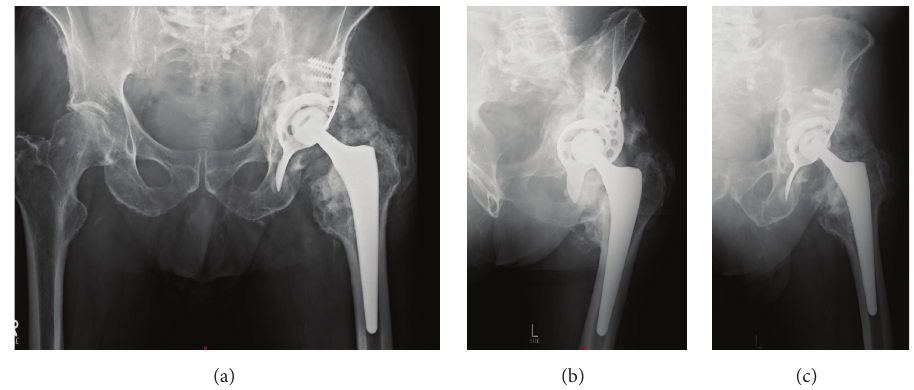
Figure 4: Follow-up X-ray (a.p., obturator and ala-view) one year postoperatively.